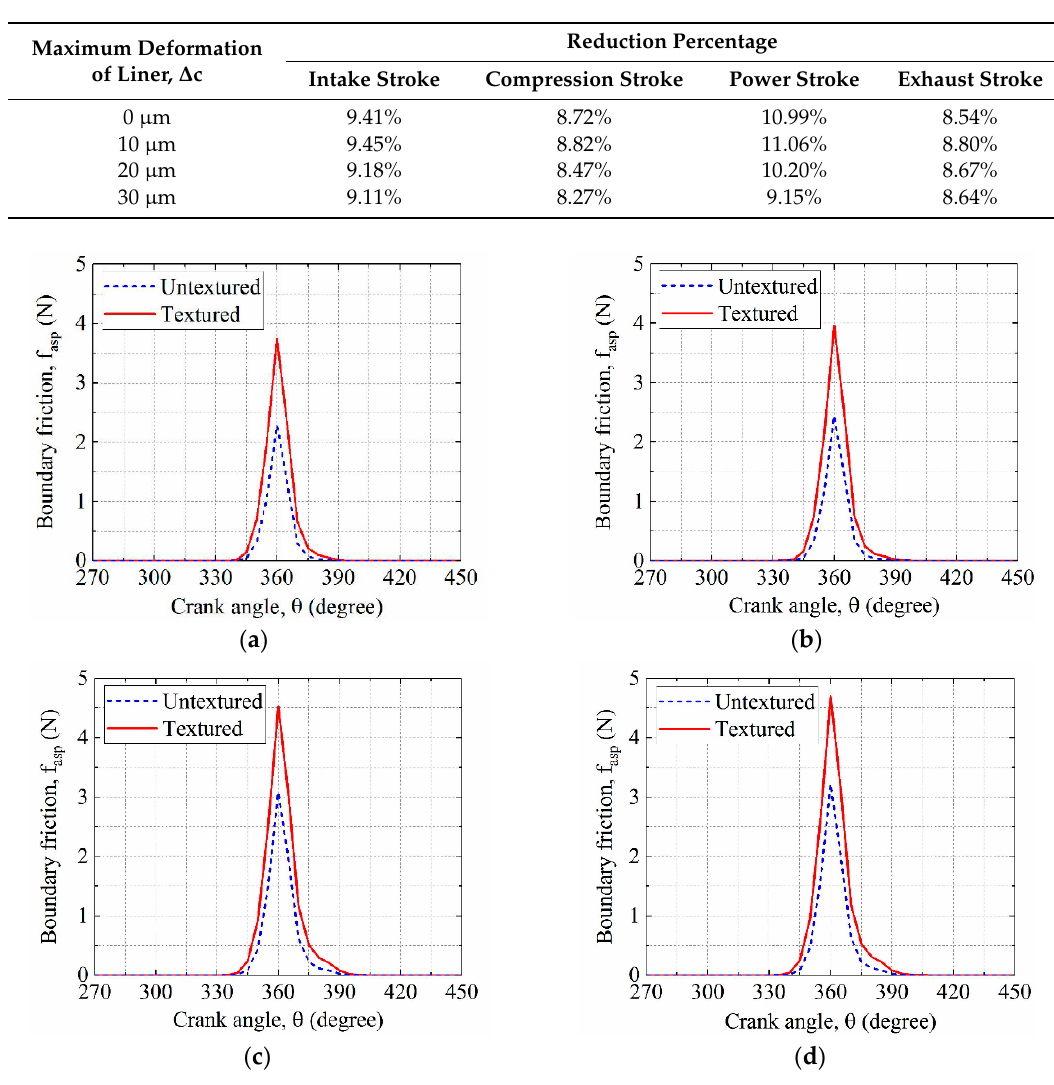
Figure 11. Boundary friction forces in the textured RLC and untextured RLC: ( a ) ∆ c is 0 µ m; ( b ) ∆ c is 10 µ m; ( c ) ∆ c is 20 µ m; and ( d ) ∆ c is 30 µ Table 3. Reduction percentages of the hydrodynamic friction force at the middle of strokes for different maximum liner deformations.